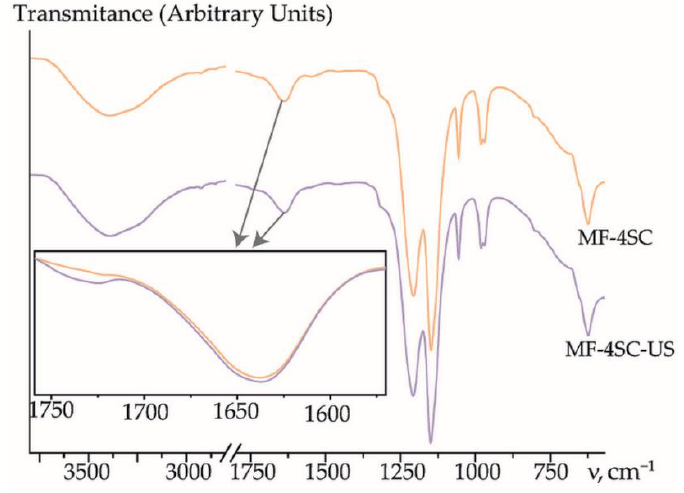
Figure 6. FTIR spectra of MF-4SC and MF-4SC-US membranes in a dry state. The IEC of the MF-4SC membrane decreased due to the US treatment of the solution from 1.00 to 0.97 mmol/g (Figure 7a). This was caused by the loss of a part of the sulfonic acid groups under the US treatment due to breaks in the polymer chains. CNTs have hydrophobic nature; hence they should be primarily located in the membrane hydropho- bic matrix, but the presence of hydrophilic groups on the surface of CNTs-X promotes their partial localization in the membrane hydrophilic pores. The IEC values of MF-4SC membranes, containing CNTs-COO − or 0.5 wt% CNTs-NH 3+ , do not differ from that of MF-4SC-US membrane if the errors of the IEC are taken into account (Figure 7a). Sulfonic acid groups on the surface of CNTs, which are present in pores, increase the membrane IEC up to 1.00–1.03 mmol/g (Figure 7a). The IEC of MF-4SC/CNTs-NH 3+ membranes decreased to 0.94–0.96 mmol/g at the dopant concentration of 1.0–1.5 wt% (Figure 7a) due to the bonding of sulfonic acid groups to the membrane. At the same time, not all amino-con- sulfonic acid groups of the membrane. Therefore, the difference between the IEC of hybrid membranes and MF-4SC-US was more pronounced upon modification by CNTs-SO 3 − , de- spite the fact that the IEC of CNTs-NH 3+ is two times more than the CNTs-SO 3 − . Besides,